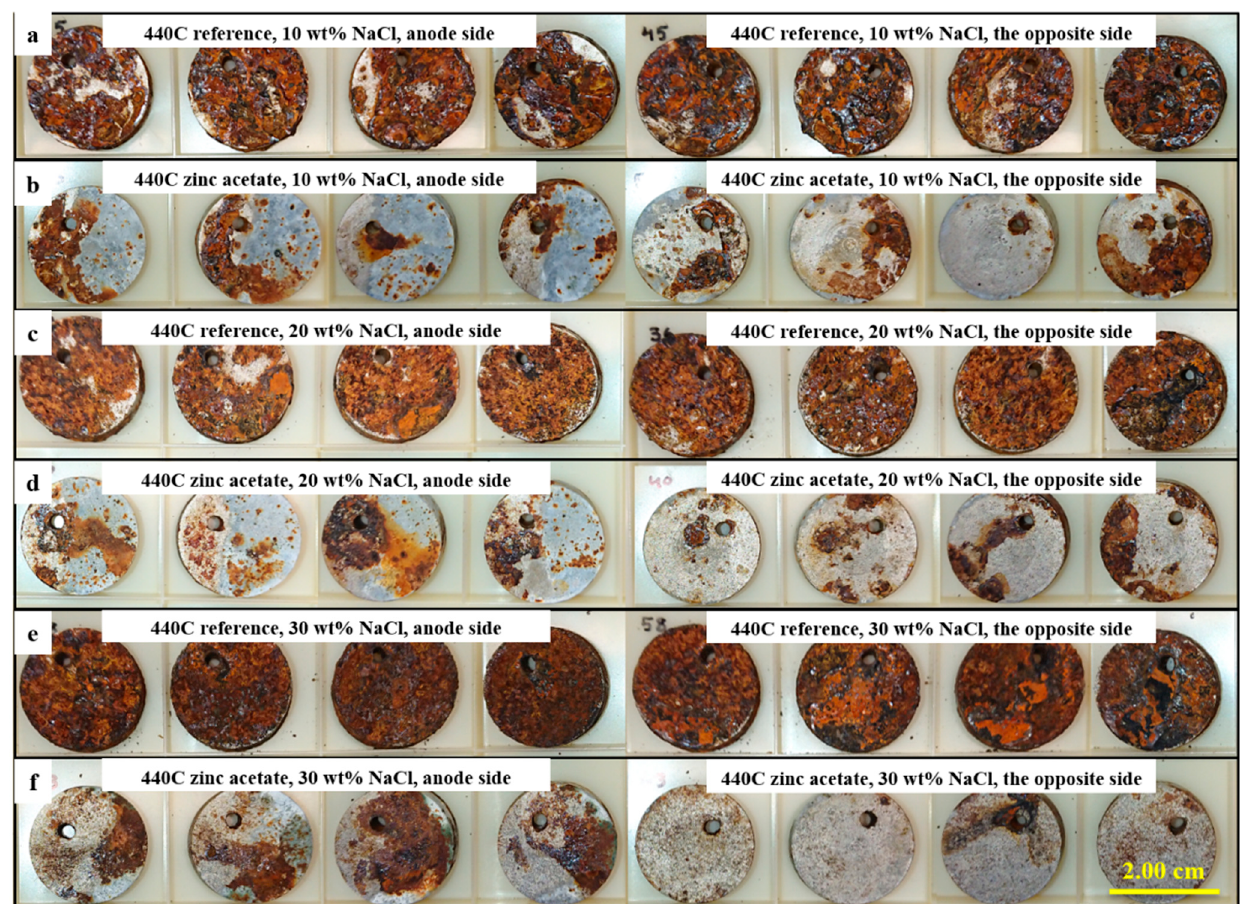
Figure 6. Images of porous 440C stainless steel samples with varying porosity of 10 wt% ( a , b ), 20 wt% ( c , d ), and 30 wt% ( e , f ) after the 240 h corrosion test. Reference samples without zinc ( a , c , e ) and the corresponding corrosion protected samples with zinc acetate electrolyte ( b , d , f ) are displayed with both sides (the anode side and the opposite side relative to the anode) of the sample. Images of the internal pore structure of the sintered 440C stainless steel samples. The amount of NaCl is 10 wt% ( a ), 20 wt% ( b ), and 30 wt% ( c ).